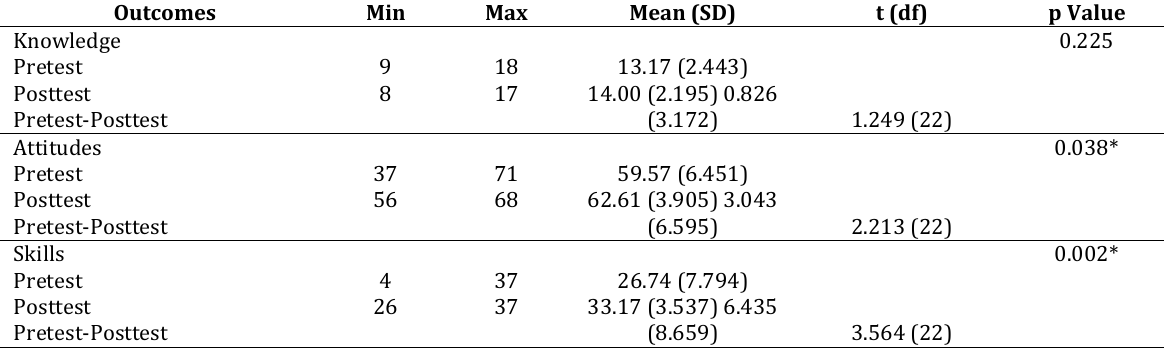
Table 8. Effects of Self-Care Training on Knowledge, Attitudes and Skills of Caregivers Regarding the Care of a Physically Disabled Child (n=